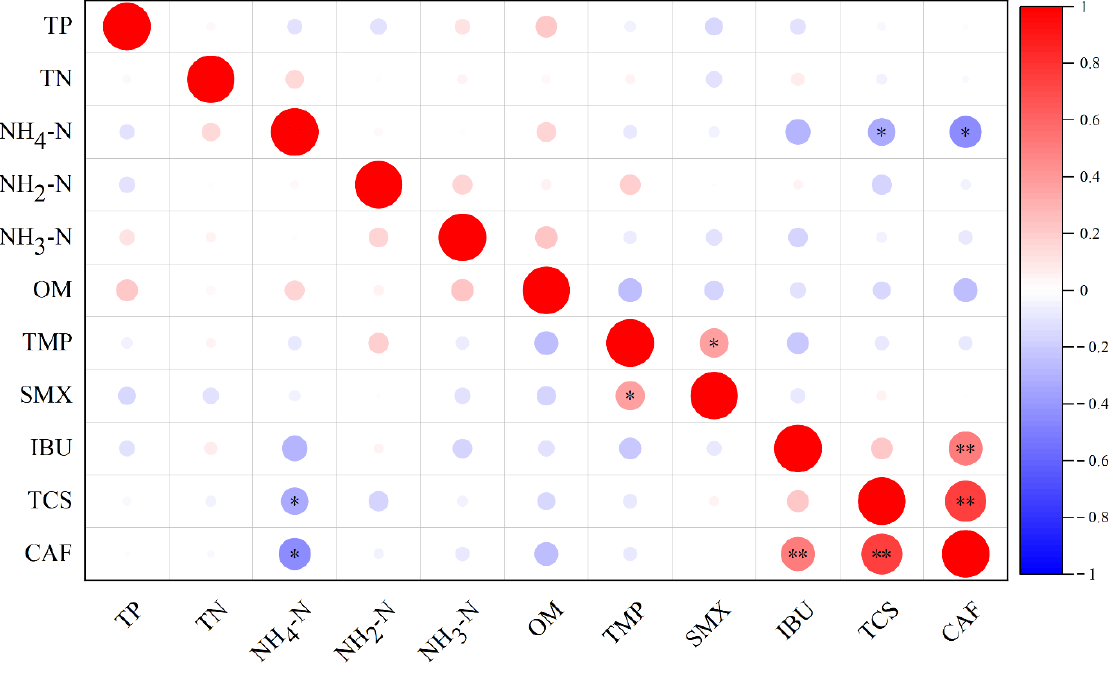
Figure 4. Pearson correlation analysis of PPCPs and environmental parameters. * Correlation is significant at the 0.05 level. ** Correlation is significant at the 0.01 level.